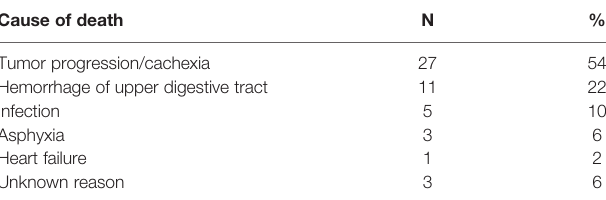
TABLE 4 | Causes of death.